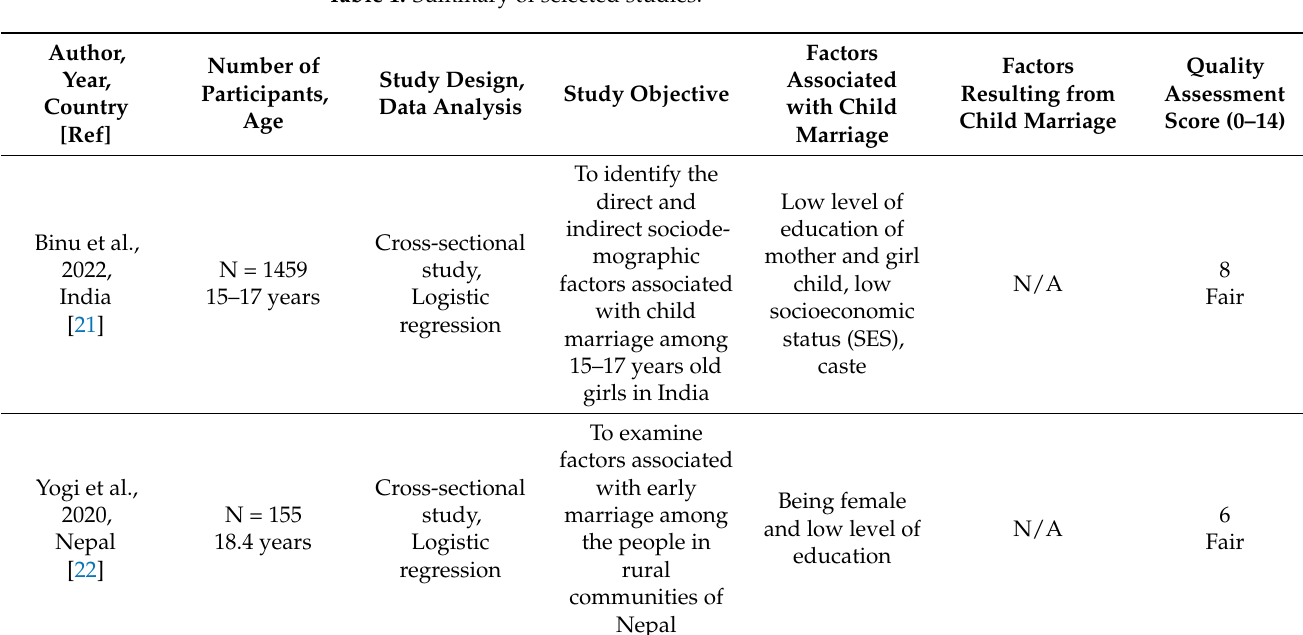
Table 1. Summary of selected studies.